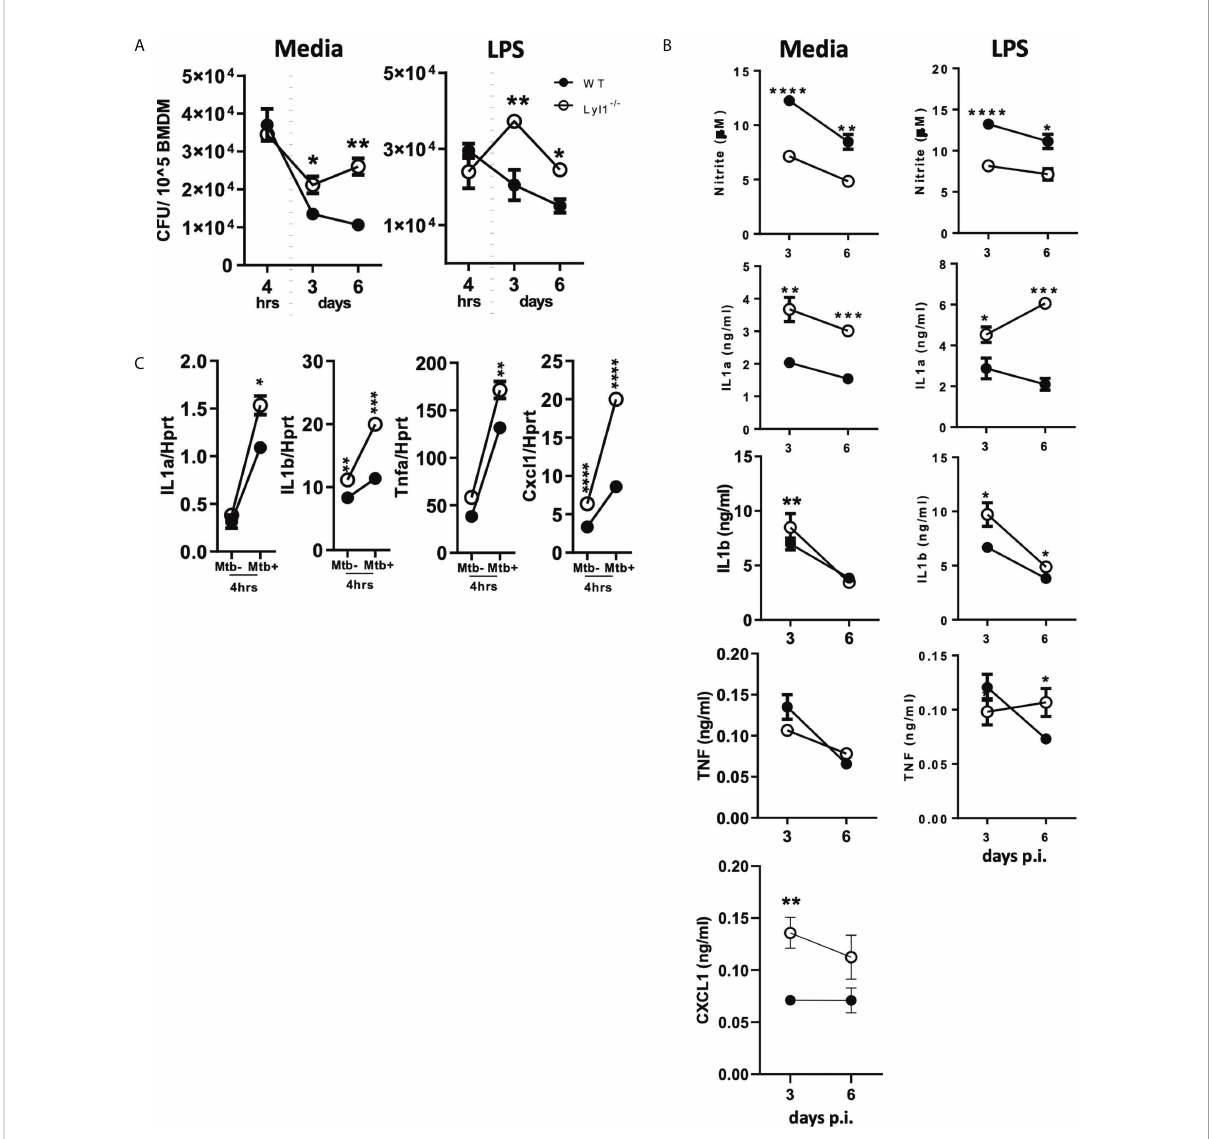
FIGURE 3 Lyl1-de fi ciency increases macrophage bacterial burden with differential effects on proin fl ammatory gene expression in response to hypervirulent Mtb HN878 in vitro . (A, B) Wild-type (WT) and Lyl1 -/- bone marrow-derived macrophage (BMDM) cells were exposed to either media or 100 ng/ ml LPS after which they were infected with Mtb HN878 with MOI:1. (A) Lysed cells (3 or 6 days post-infection) were plated for intracellular bacterial burden and (B) supernatants (3 or 6 days post-infection) were collected for cytokine chemokine production by ELISA. Nitrite levels were measured by Griess assay. (C) RNA was collected from WT and Lyl1 -/- BMDM 4 hrs post-Mtb HN878 (MOI:1) infection, synthesized to cDNA by two-step PCR, and qPCR performed for mRNA expression. Data represented demonstrates technical replicates and the error bar denotes Mean ± SEM. Data shown are representative of 2-4 independent experiments. Unpaired student t-test analysis at *p < 0.05, **p < 0.01, ***p < 0.001, ****p < 0.0001 to determine signi fi